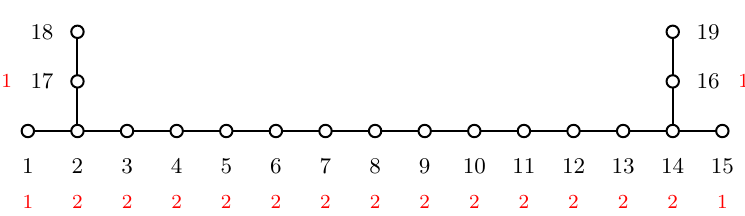
Figure 2. Extended Dynkin diagram for the II 1 ; 17 lattice, with labels showing the embedding of (cid:0) 16 . The Kac marks of the extended SO(32) diagram are shown in red. Node